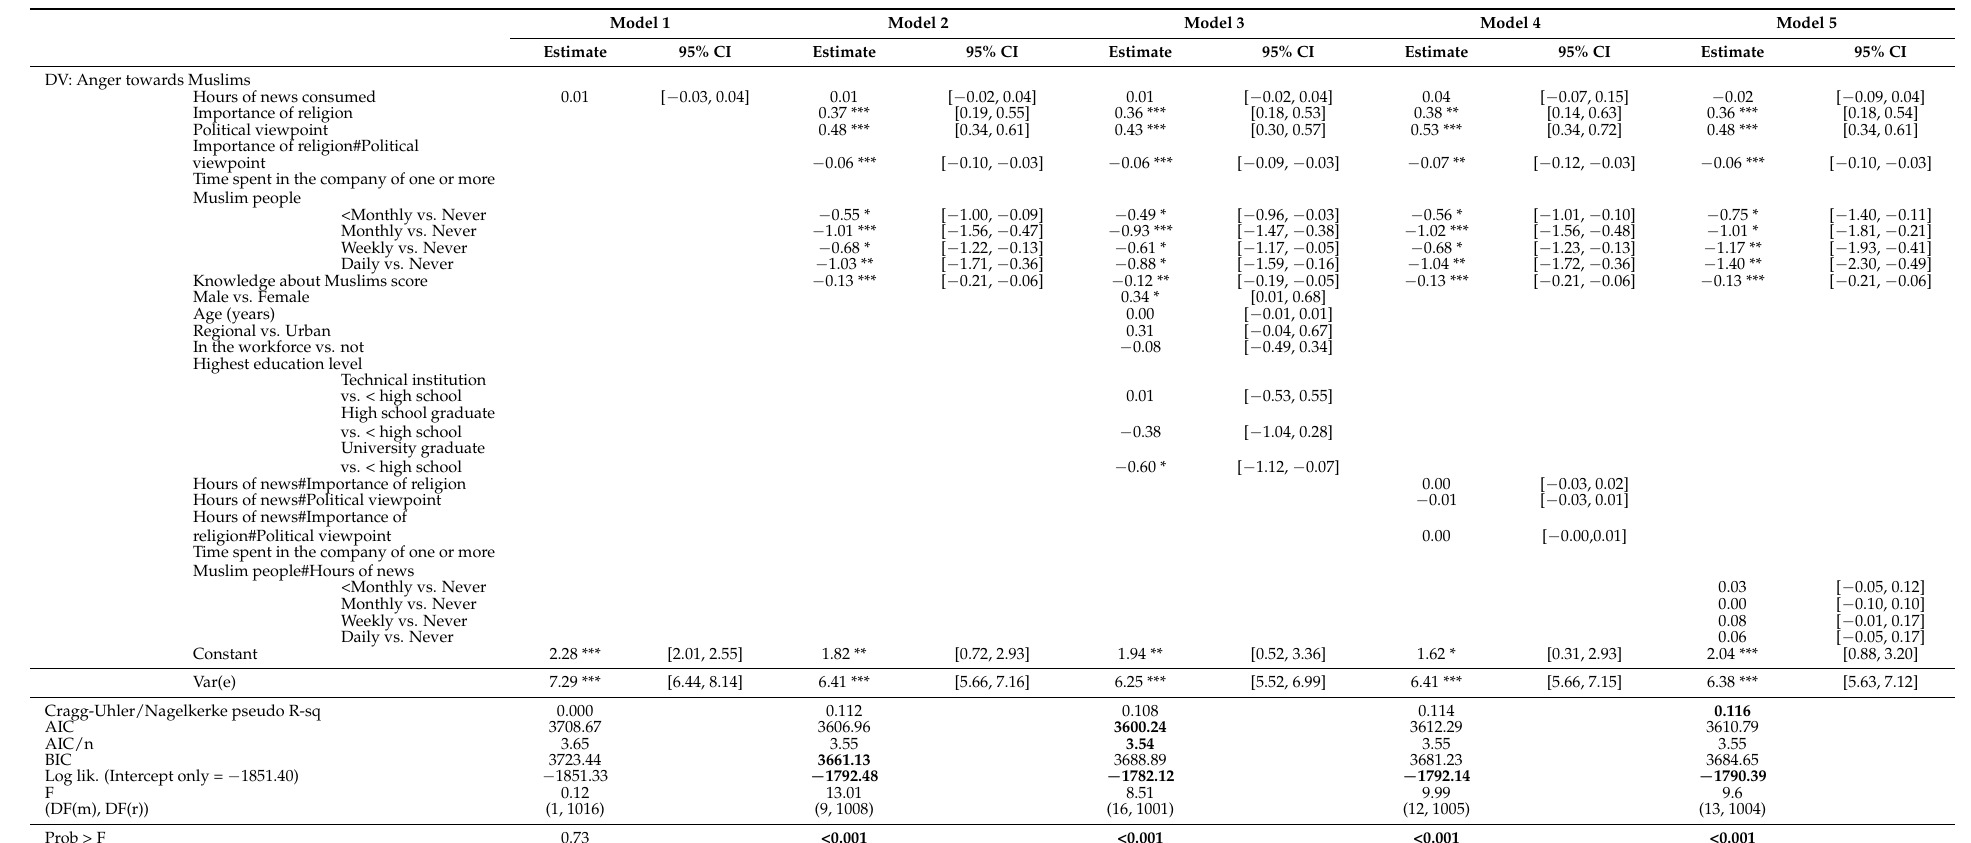
Table 1. Model comparison: Predicting anger towards Muslims using Australian survey